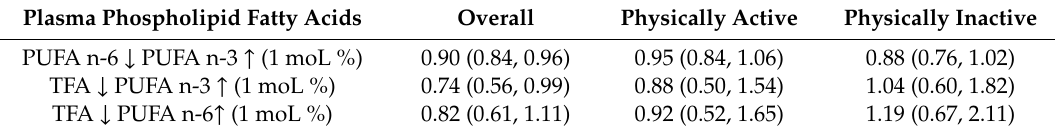
Table A4. Odds ratios a (95% CIs) of CHD associated with 1 moL % substitutions between plasma phospholipid fatty acid groups stratified by physical activity levels in the matched case-control study ( N = 2428).